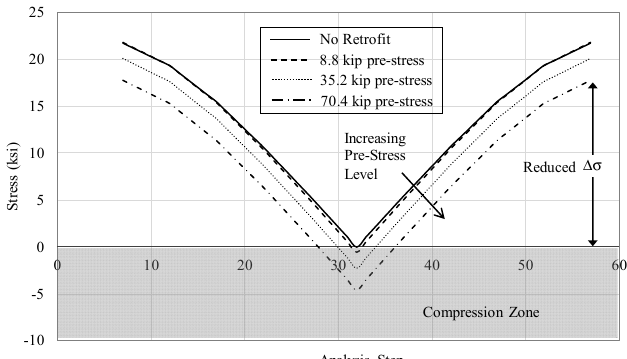
Figure 12. Stress range shift in section F13 due to the applied CFRP pre-stress (one lockage cycle).